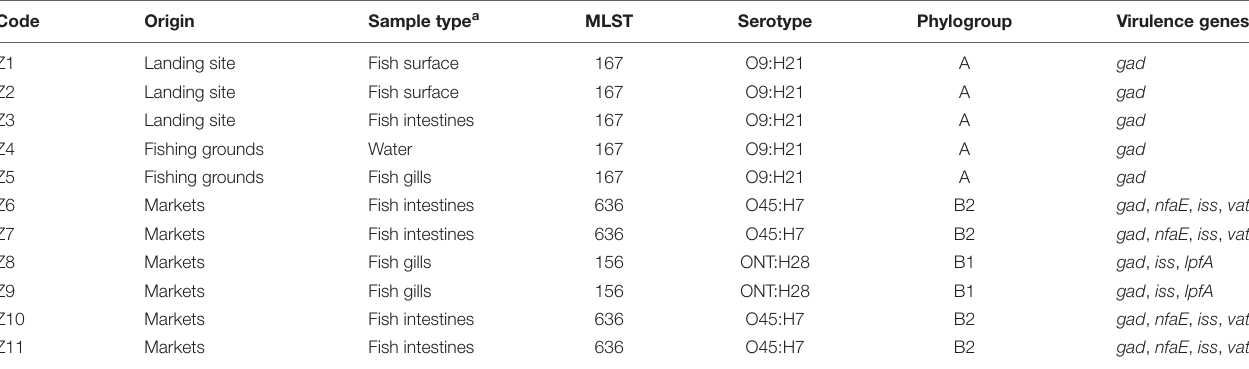
TABLE 2 | Genomic characterization of ESBL-producing Escherichia coli isolated in Nile